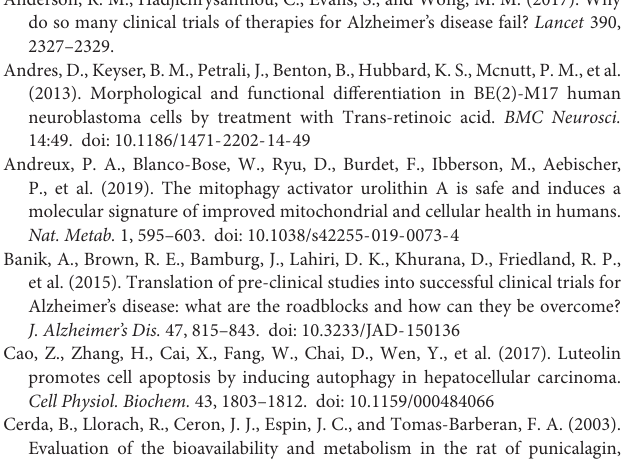
Supplementary Figure 6 | Relative ATP levels for the combination 1 (D 5 L 10 ) and its components. ATP levels for the combination 6 (D 5 L 10 ) and its constituents were determined using CellTiter Glo assay. Data are expressed as mean ± SD from four ( N = 4) independent experiments. Differences are significant at a P < 0.001 vs. vehicle control, ∗∗∗ P < 0.001 vs. A β 1 − 42 -treated control, DHA 5 µ M. Supplementary Figure 7 | Relative ATP levels for the combination 7 (D 10 L 10 ) and its components. ATP levels for the combination 7 (D 10 L 10 ) and its constituents were determined using CellTiter Glo assay. Data are expressed as mean ± SD from four ( N = 4) independent experiments. Differences are significant at